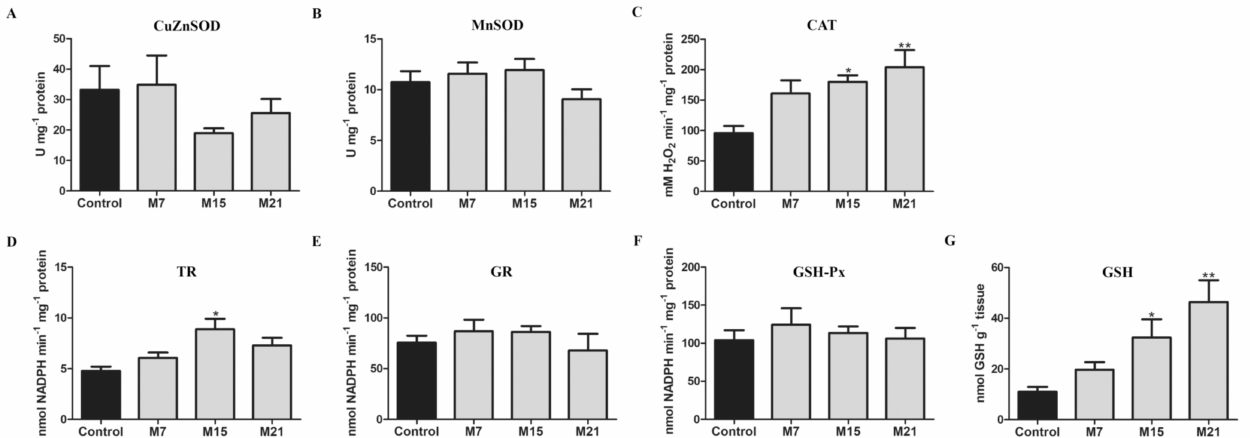
Figure 2. The activity of CuZnSOD ( A ), MnSOD ( B ), CAT ( C ), TR ( D ), GR ( E ), GSH-Px ( F ), and GSH content ( G ) in rat brown adipose tissue of the control (black) and hypothyroid groups (gray) treated with methimazole for 7 (M7), 15 (M15), and 21 (M21) days, respectively. Enzyme activity is expressed in absolute units in U mg-1 protein (A, B), mM H 2 O 2 min − 1 mg − 1 protein ( C ), nM NADPH min − 1 mg − 1 protein ( D – F ), and nmol GSH g − 1 tissue ( G ). Bars represent the mean ± SEM. Compared to control, * p < 0.05, ** p < 0.01. Abbreviations: CuZn- and Mn-superoxide dismutase (CuZnSOD and MnSOD, respectively), catalase (CAT), thioredoxin reductase (TR), glutathione reductase (GR), glutathione peroxidase (GSH-Px), glutathione